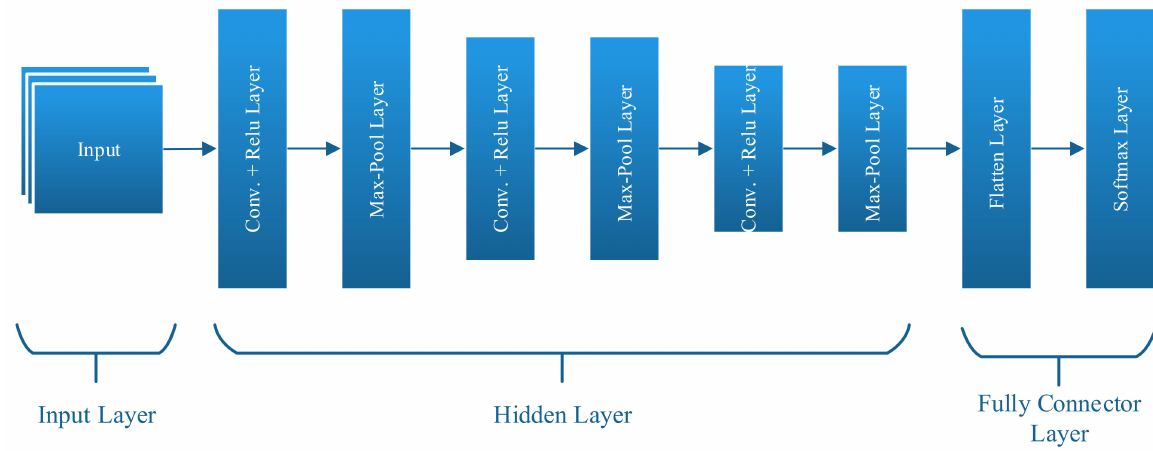
Figure 3. Architecture of convolutional neural